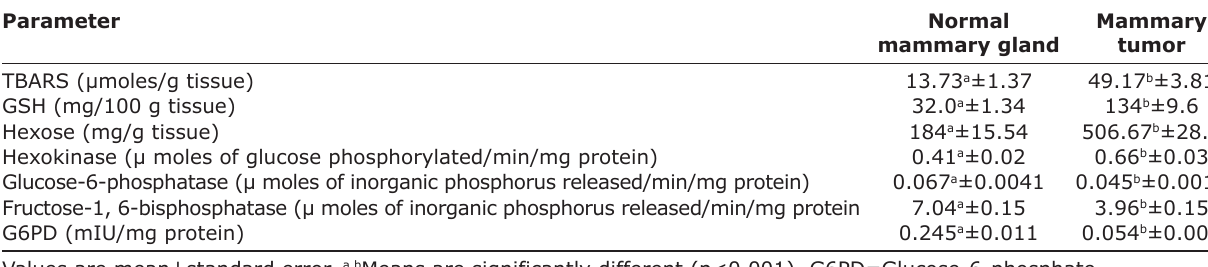
Table-1: Altered carbohydrate metabolism in canine mammary tumors.